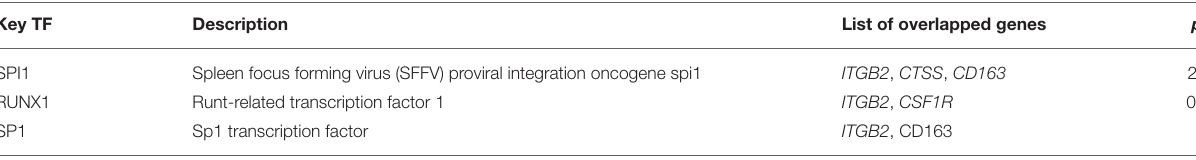
TABLE 2 | Key transcriptional factors of the cluster genes. Key TF